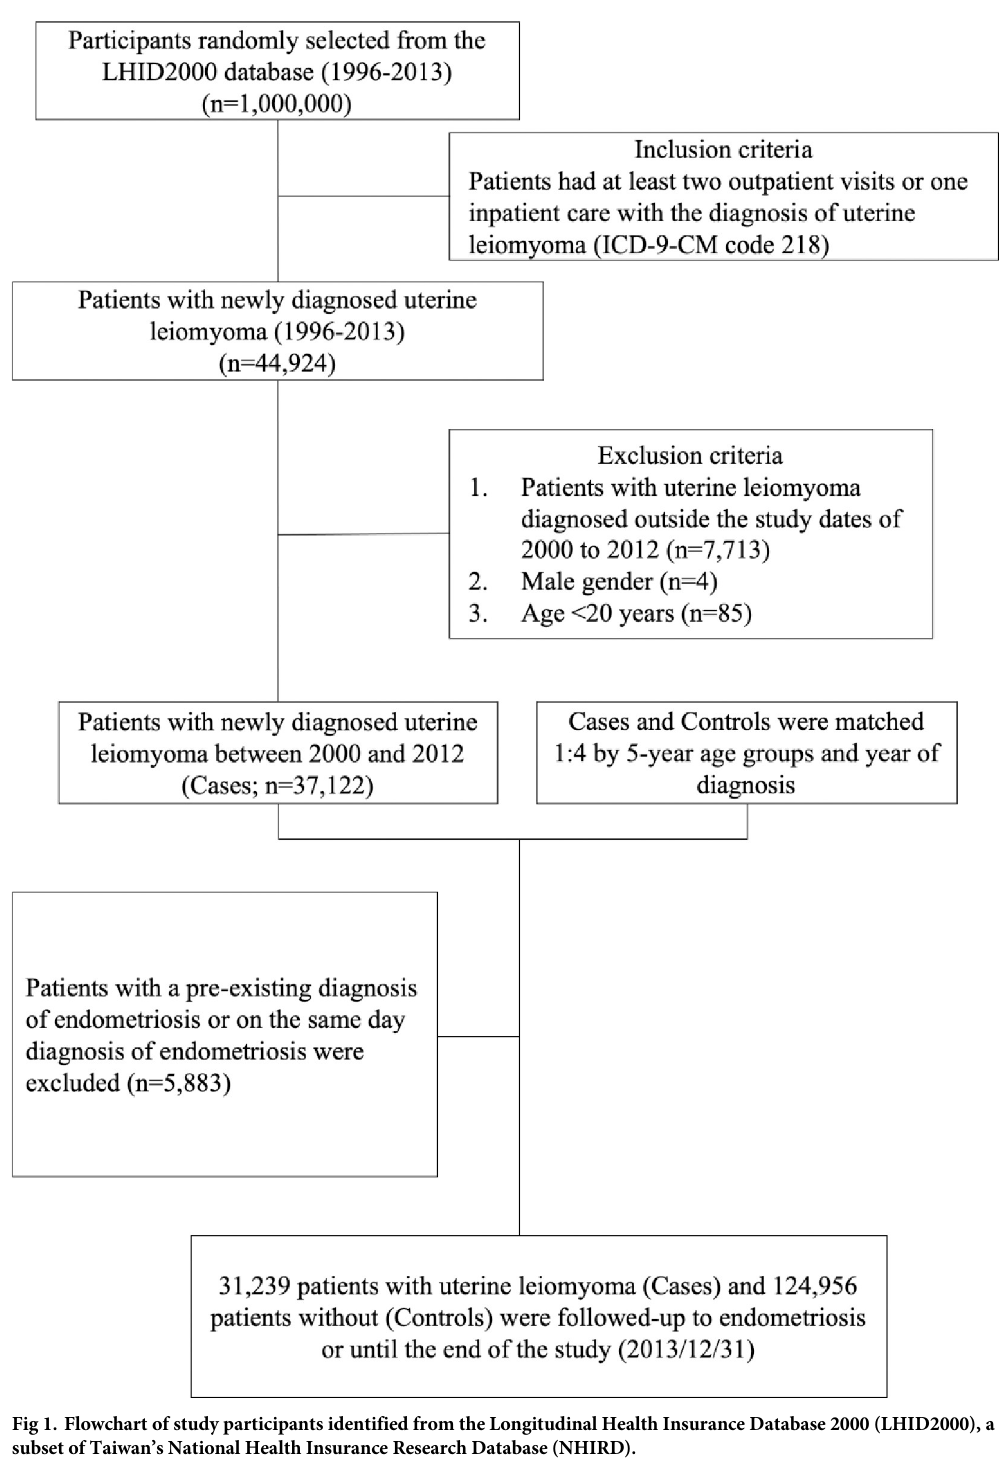
Fig 1. Flowchart of study participants identified from the Longitudinal Health Insurance Database 2000 (LHID2000), a subset of Taiwan’s National Health Insurance Research Database (NHIRD).